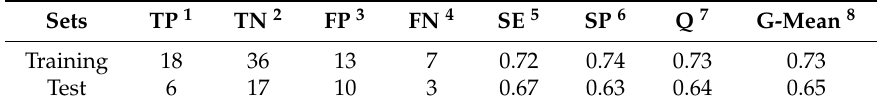
Table 8. Balance the moderate-active-to-active and inactive classes for the best NMR RF model of HCT116 activity classes for the Training and Test Sets.